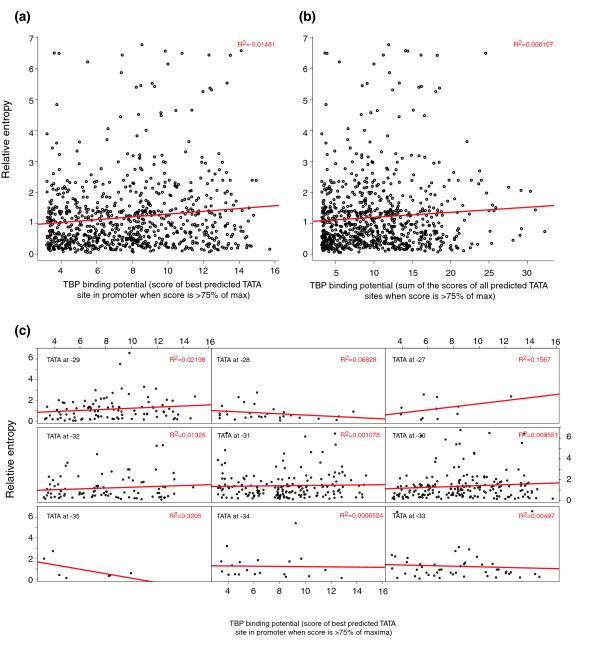
Exploration of the effects of TATA-TBP interaction strength on tissue specificity. We investigated possible dependencies between tissue specificity measured by relative entropy and three aspects of TATA-TBP interaction potential in the -40 to -19 region of each promoter: (a) the predicted TATA box with the highest score fulfilling the score threshold criteria defined in Materials and methods; (b) the sum of all predicted TATA boxes each fulfilling the specified score criteria; and (c) the predicted TATA box with the highest score fulfilling certain score threshold criteria, given TATA box location. For clarity, each plot in panel c corresponds to one type of TATA-TSS spacing, and can be considered a subset of the data points in panel a. The subdivision of the TATA-containing promoters into the different TATA-TSS spacing classes confers no additional support for a significant relation between TBP-TATA interaction strength and transcriptional specificity. In combination with panel a, this strongly suggests that TATA-TSS distance is more strongly linked to tissue specificity than the TATA-TBP interaction strength within TATA-driven core promoters. TBP, TATA box binding protein; TSS, transcription start site.